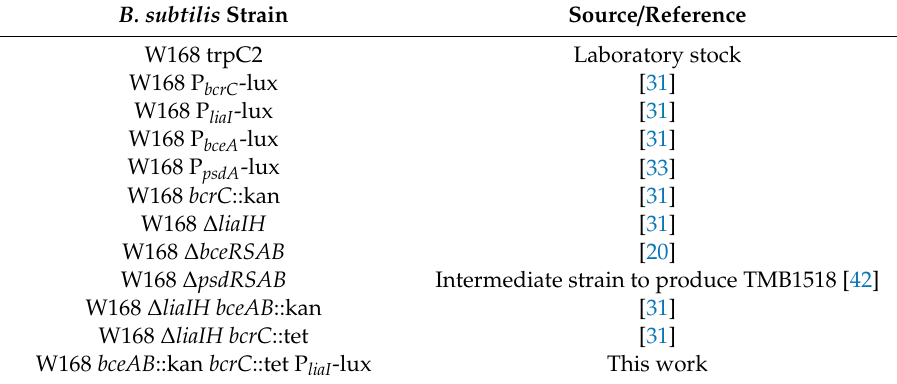
Table 1. Strains used in this study.